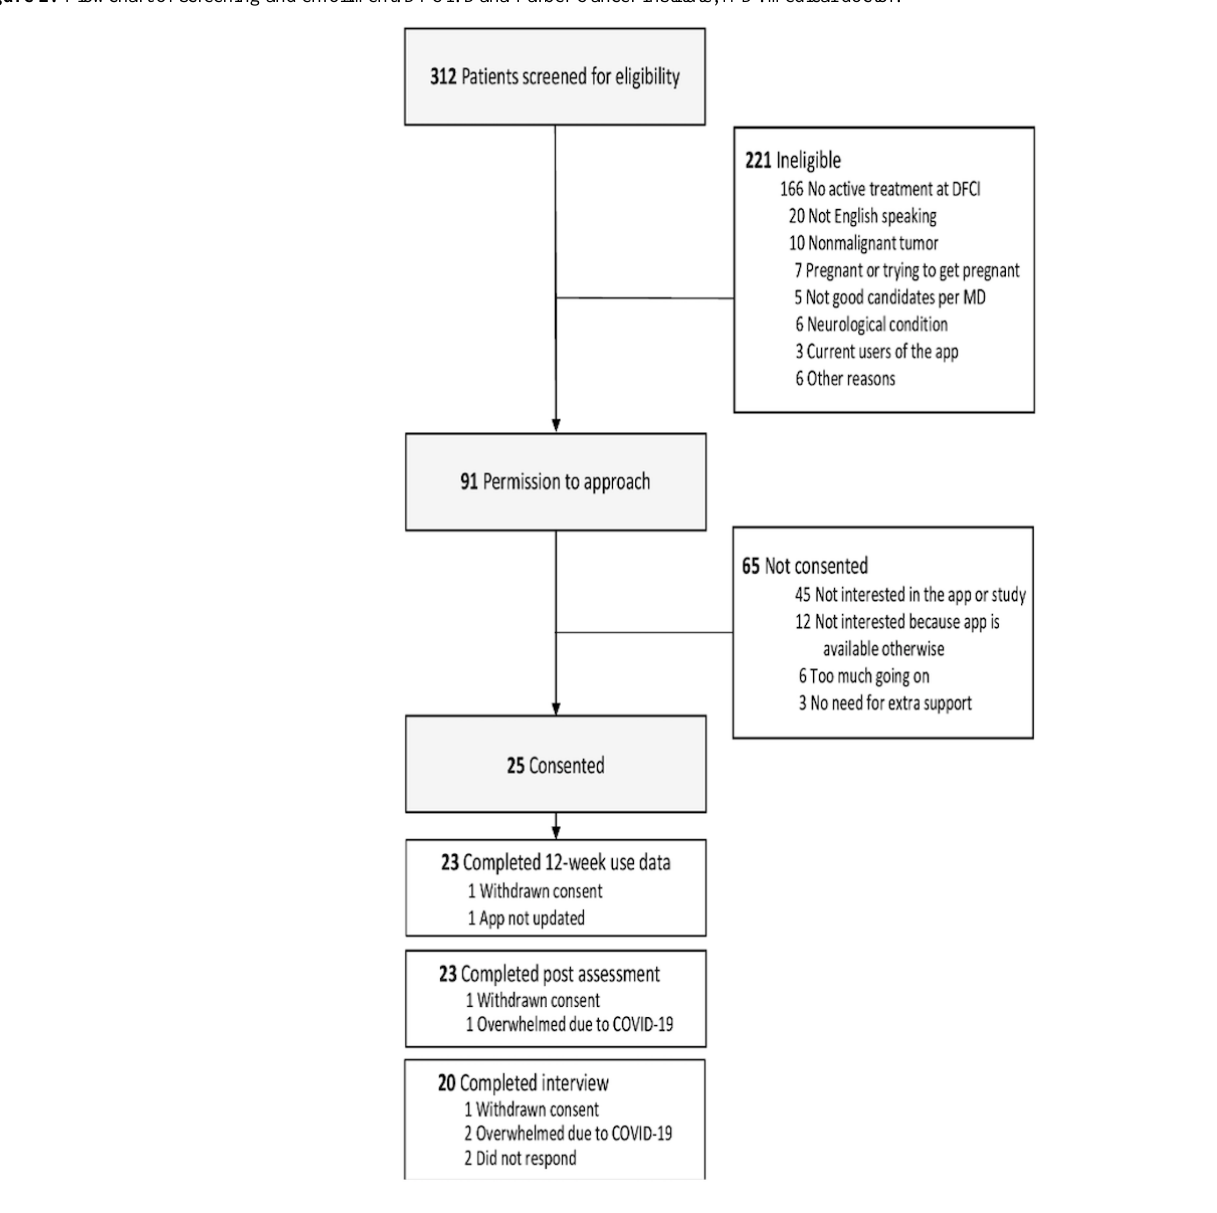
Figure 2. Flowchart of screening and enrollment. DFCI: Dana-Farber Cancer Institute; MD: medical